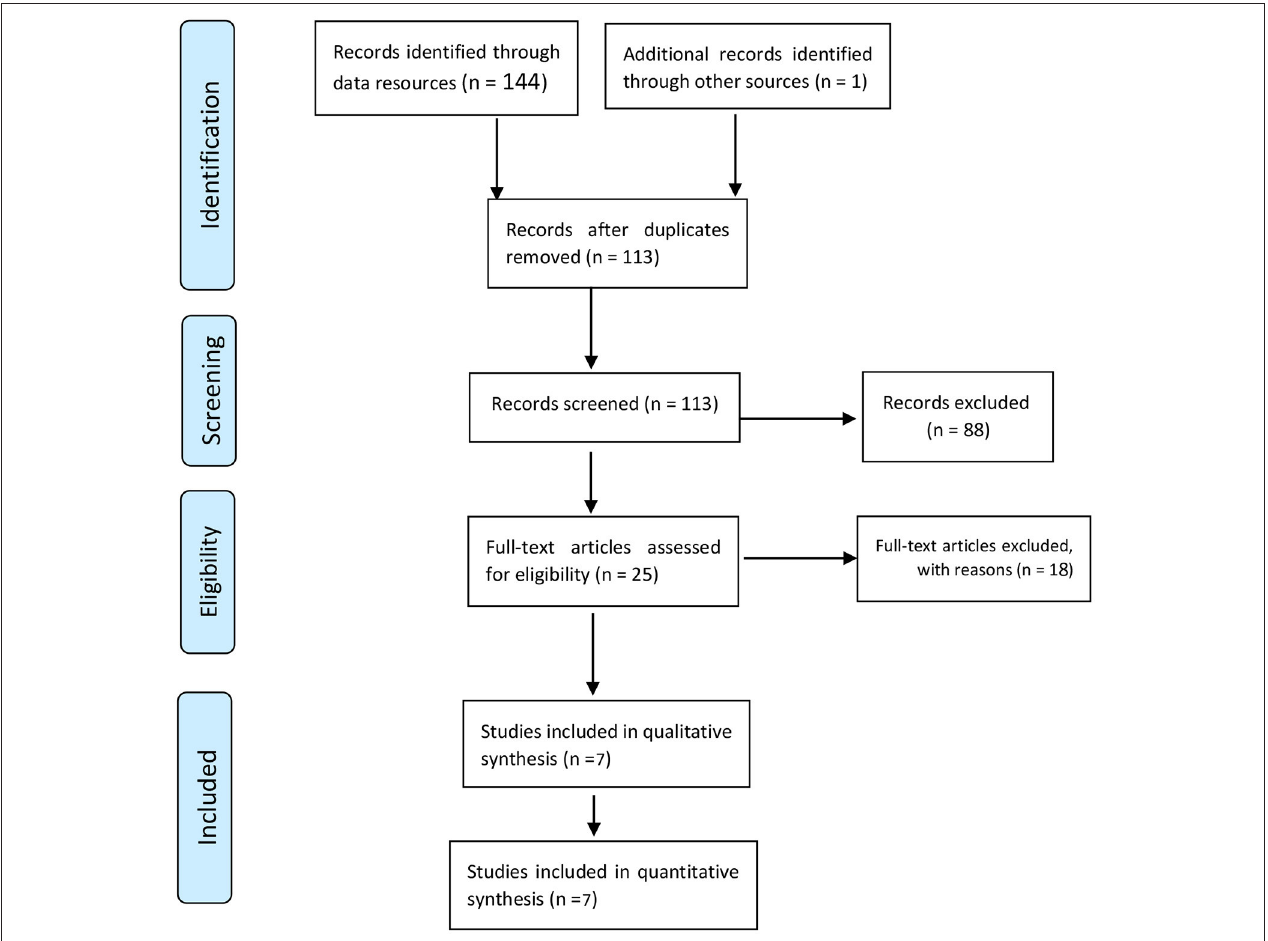
FIGURE 1 | Flowchart of the selection of studies based on PRISMA.